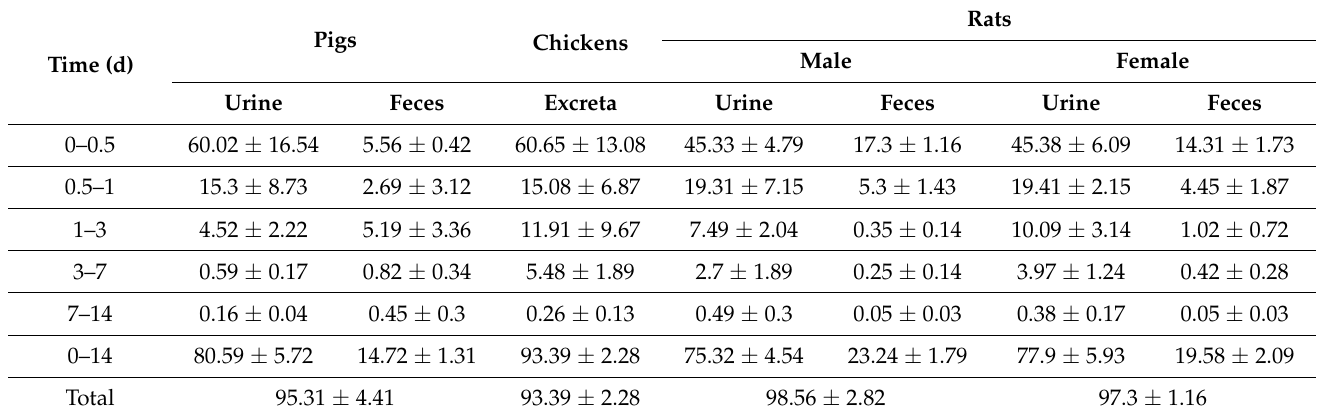
Table 1. Recovery of total radioactivity in the urine and feces of pigs, chickens and rats. After administration of [ 3 H]-SMZ at 25 mg/kg b.w.